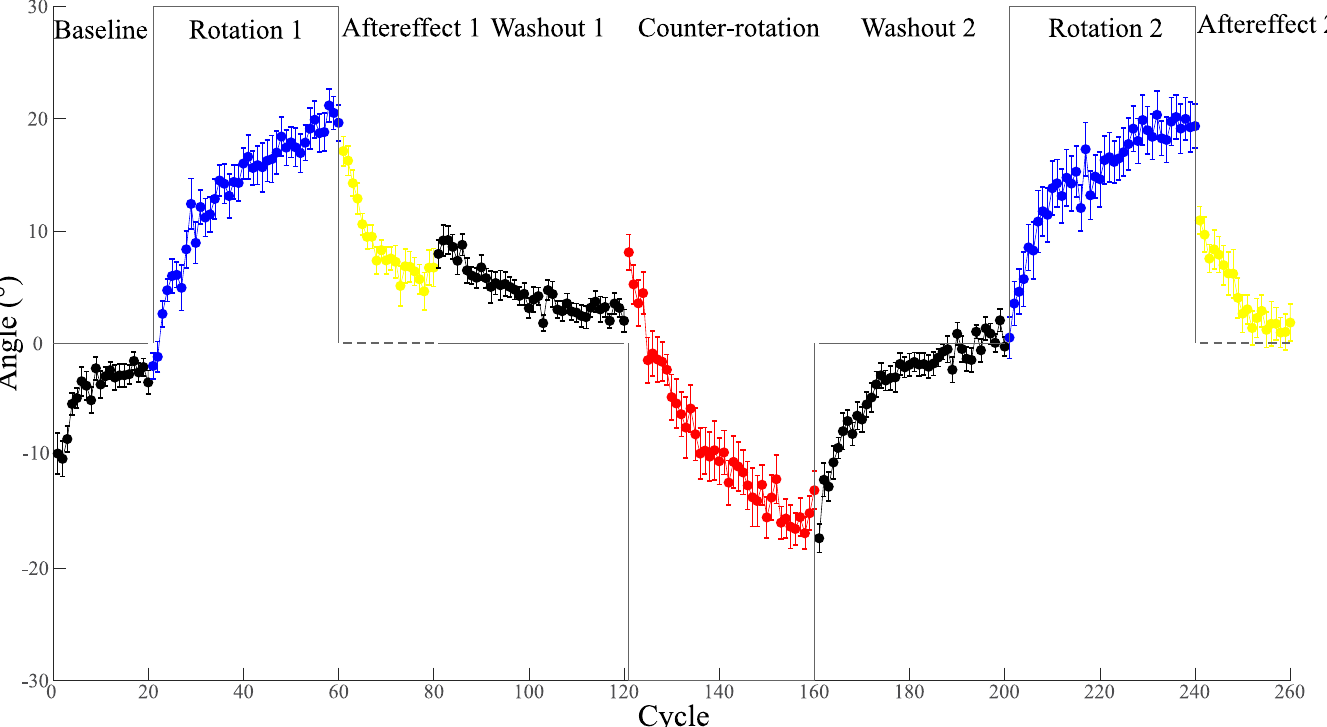
Fig 2. Learning data for all the 8 phases for the Control group. The grey lines denote the perfect hand movement direction to counter the visual perturbation. The dashed lines denote no visual cursor feedback. Positive angle denotes CW direction. Error bars denote SEM.